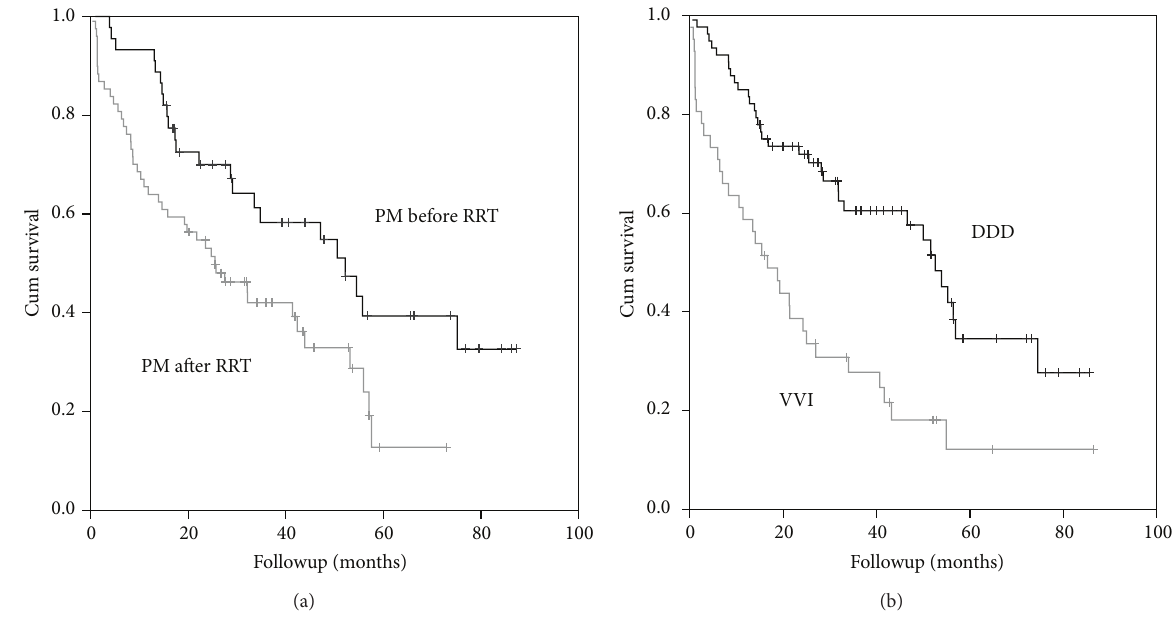
Figure 4: KM survival curves. (a) Mortality related to RRT; the grey lines correspond to the group of PM patients who received the device while on RRT and the black line corresponds to those who received the PM before entering the RRT program. Log rank (mantel-Cox); Chi- Square 6,2 df 1; 𝑃 = 0.012 . (b) Mortality regarding PM mode, DDD versus VVI pacing. The grey line corresponds to the VVI PMs and the black line to the DDD devices. Log rank (mantel-Cox) Chi-Square 11,31 df 1; 𝑃 = 0.001